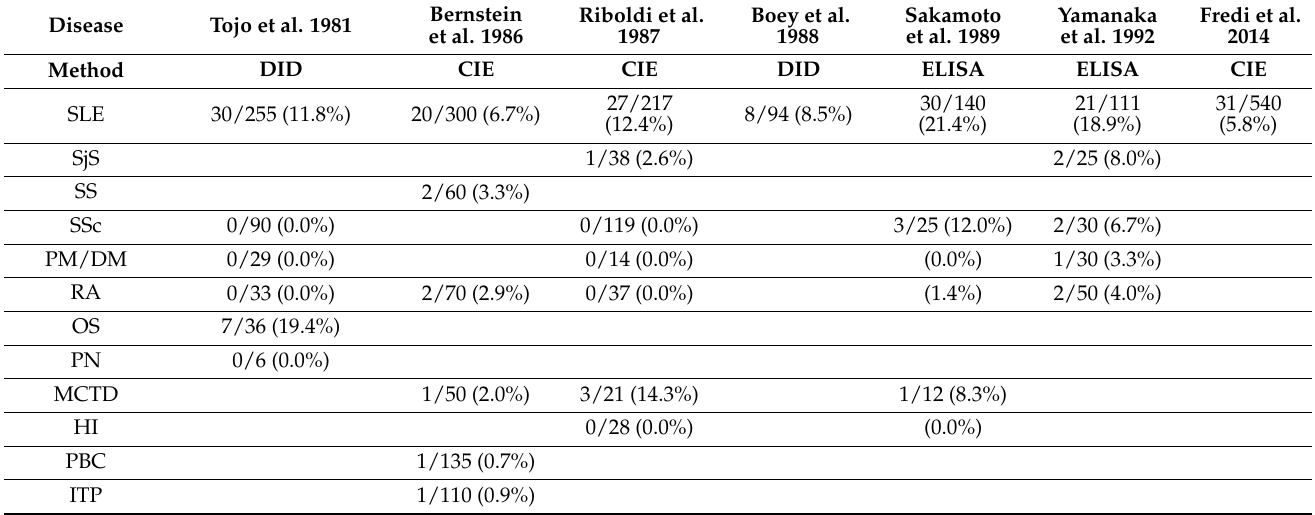
Table 2. Prevalence of anti-Ki/SL antibodies in different